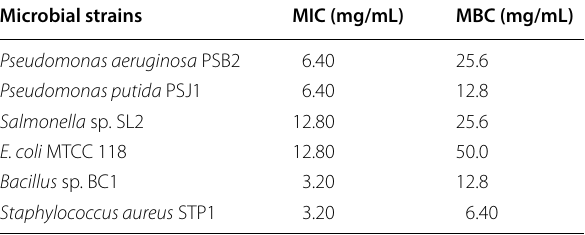
inhibitory concentrations (MIC) and minimum bactericidal